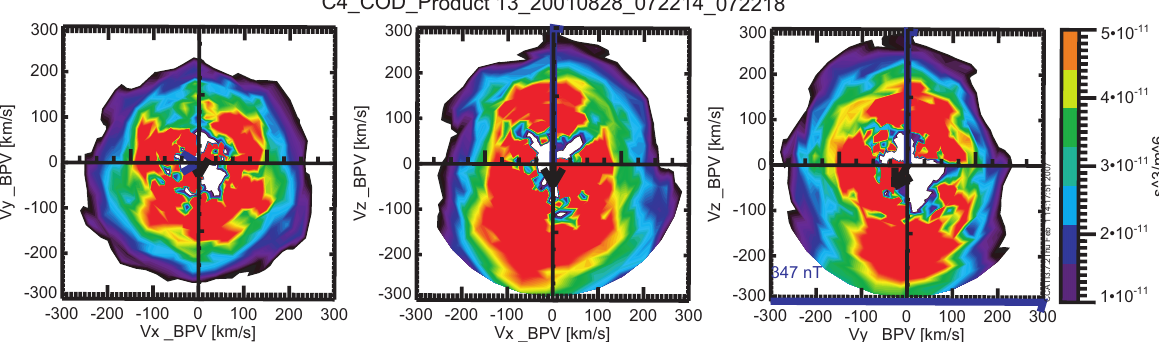
Fig. 9. Contours of the distribution function (units shown on the color bar) observed by CIS on C4 for the time interval 07:22:14 to 07:22:18. The coordinate system is BPV (B-parallel-v) with the magnetic field along the +z axis.